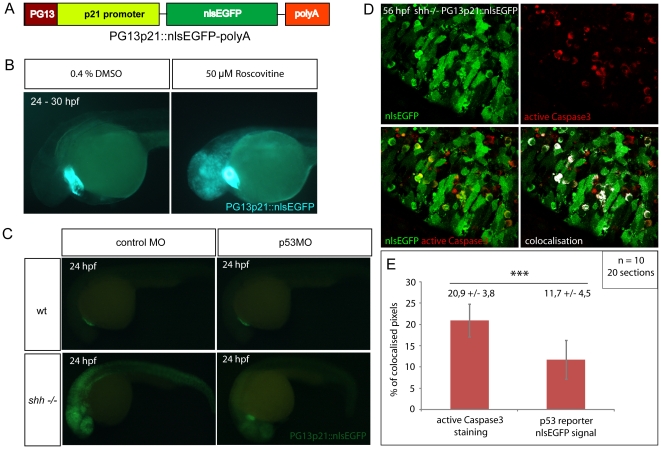
Zebrafish p53 reporter line construction and verification.(A) p53 reporter PG13p21::nlsEGFP-polyA was constructed using Tol2kit as described in Materials and methods. It consists of the p21 promoter fused with p53-binding enhancer sequence PG13, nlsEGFP coding sequence and a polyadenylation signal (polyA). (B) Wild-type embryos carrying the p53 reporter transgene were incubated for 6 hours at 24 hpf with either 50 µM Roscovitine or 0.4% DMSO diluted in E3 medium. DMSO-treated embryos did not show any significant expression of the reporter (right), whereas roscovitine-treated ones expressed p53 reporter at a high level (left). All embryos showed green-heart transgenesis marker. The experiment was repeated three times and 20 embryos were used for each treatment. (C) p53 morpholino but not 4-mismatch control morpholino injection suppressed expression of PG13p21::nlsEGFP p53 reporter in shh
−/− mutant embryos at 24 hpf. Both injections had no effect on p53 reporter expression in the wild-type embryos. (D) Anti-active Caspase3 staining of cells in the shh
−/− mutant retina at 56 hpf expressing p53 reporter transgene PG13p21::nlsEGFP. Most cells positive for active Caspase3 also expressed p53 reporter transgene. Single channel, overlay and co-localisation analysis images are shown. (E) Quantification of co-localisation of active Caspase3 staining and nlsEGFP p53 reporter signal. Co-localised pixels made up 20,9 +/− 3,8% of total active Caspase3 pixels and 11,7 +/− 4,5% of total nlsEGFP pixels. Quantifications were performed on 20 retinal section images from 10 embryos. Asterisks (***) indicate a significant statistical difference between the proportions (t-test, P-value<0,001).